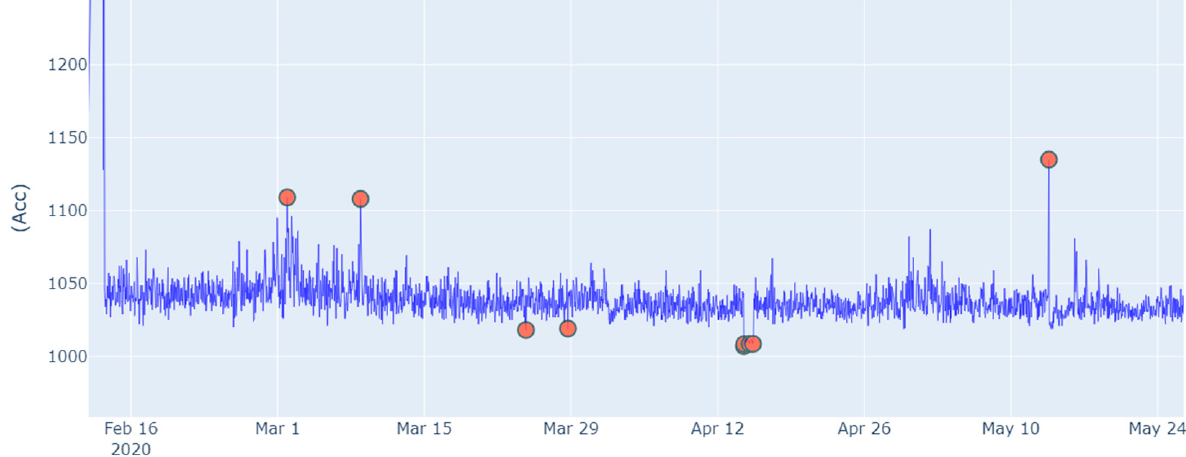
Figure 7. Projection of the anomalies detected in ‘Boiler 2’ on the vibration graph of the ‘Boiler